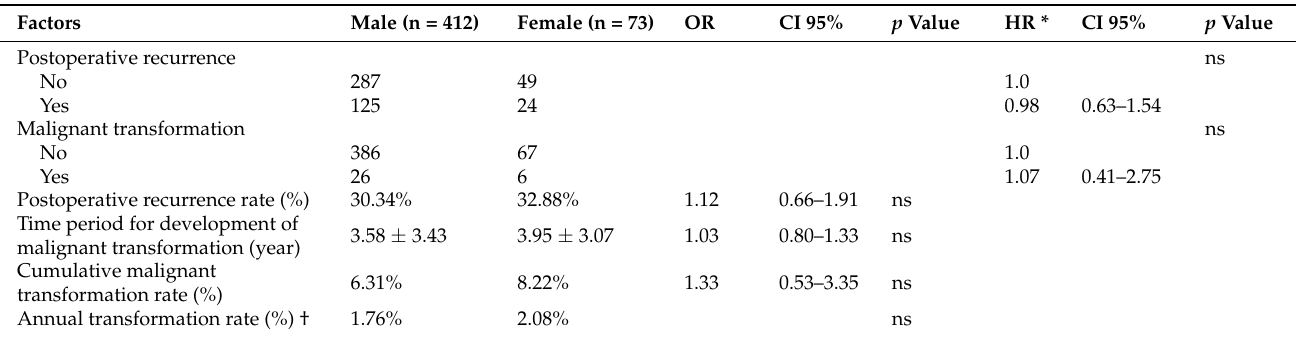
Table 2. The demographic data, and clinicopathological characteristics oral leukoplakia in male (n = 412) and female (n = 73) patients.